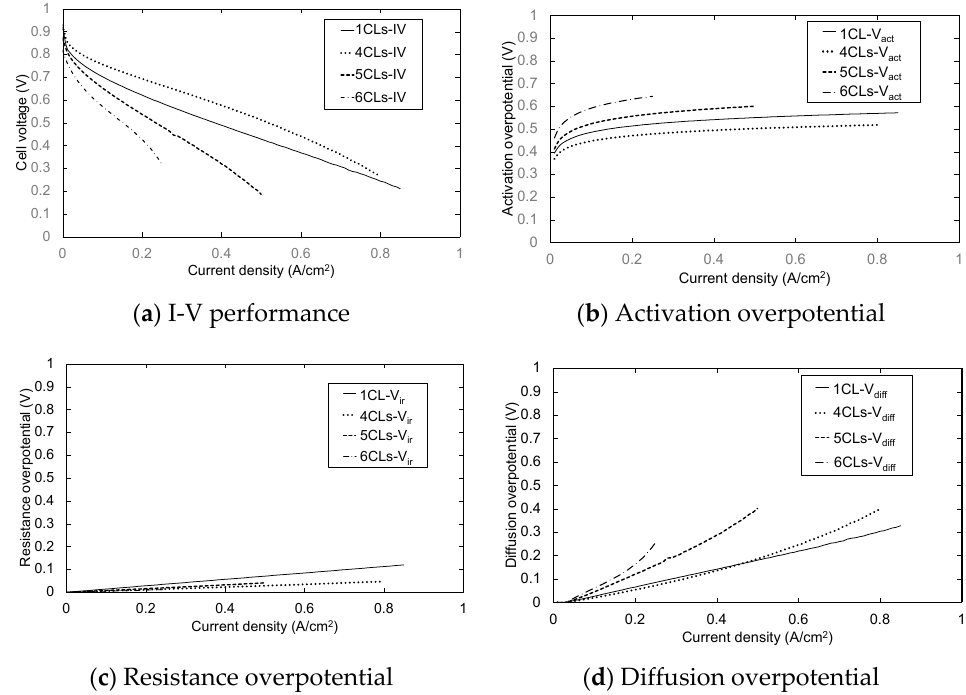
Figure 4. Influence of the number of layers on ( a ) I-V performance, ( b ) activation overpotential, ( c ) resistance overpotential and ( d ) diffusion overpotential.